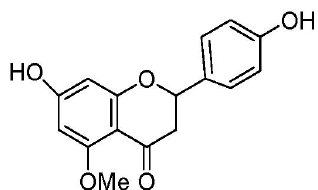
Figure 1. Chemical structure of 7- O